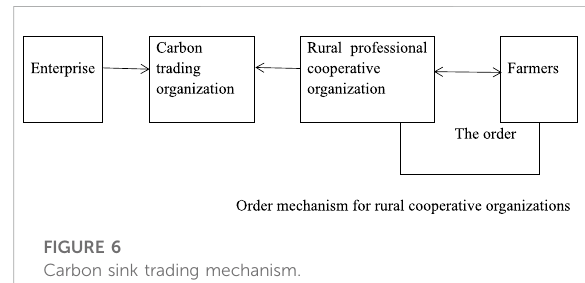
FIGURE 6 Carbon sink trading